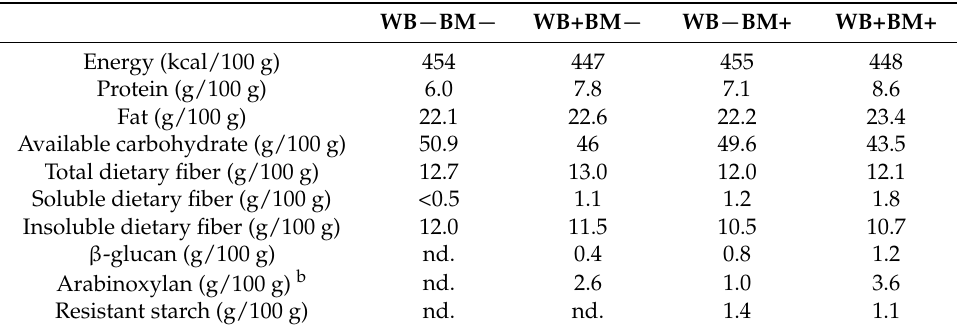
Table 3. Nutritional profiles of test foods.